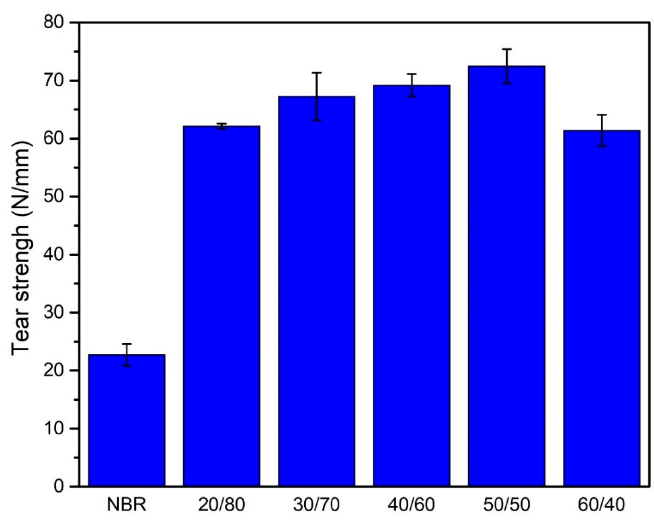
Figure 3. The dependence of WLF loading to tear strength.